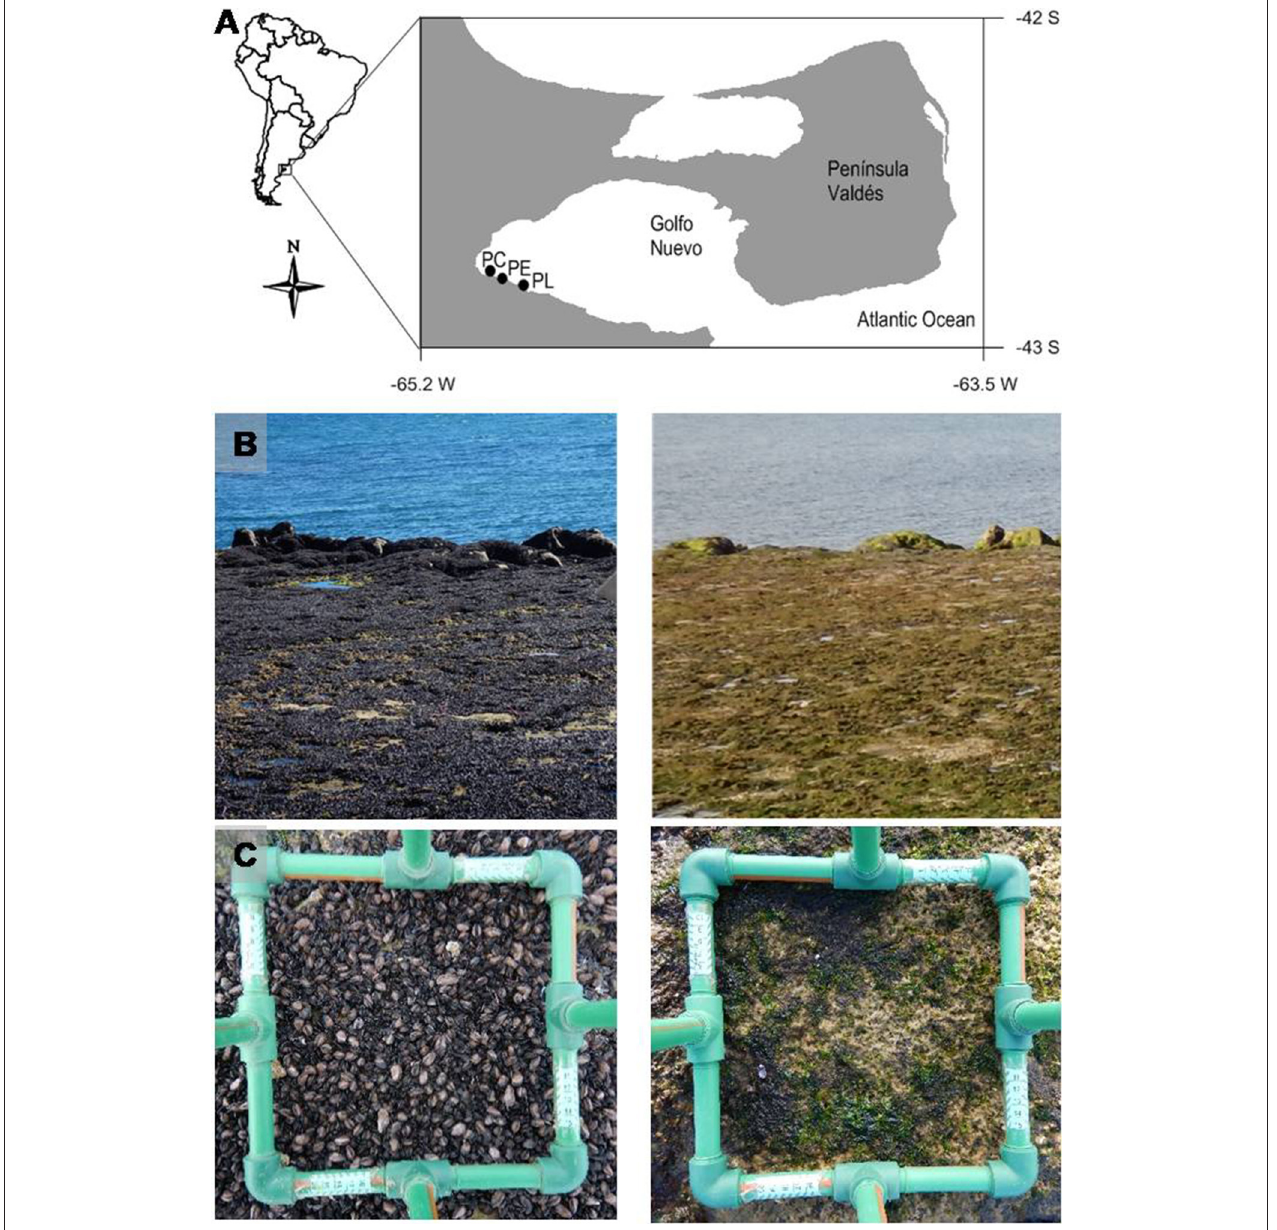
FIGURE 1 | (A) Map of South America showing the location of the study sites. PC, Punta Cuevas; PE, Punta Este; and PL, Punta Loma. (B) Punta Loma mid intertidal rocky shore showing the typical cover of the mussel bed in February 2018 (left) and in May 2019 (right). (C) Plots in the mid intertidal of Punta Cuevas in October 2018 (left) and after the mass mortality event, when mussels were absent on all horizontal surfaces in June 2019